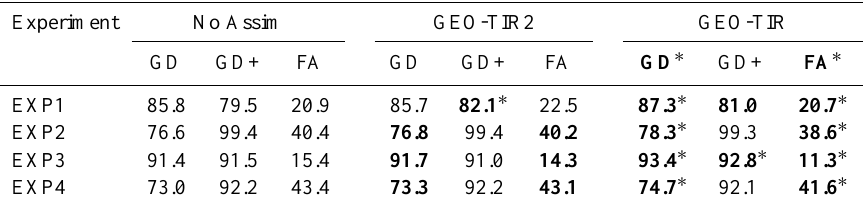
Table 6. Scores for O 3 8-h running average daily maximum (percentage of good detection (GD), percentage of correct forecast above threshold (GD+), percentage of false alarm (FA)) obtained over Europe during July and August 2009 by comparing the control run to the nature run (2nd column), the assimilation run with GEOTIR2 to the nature run (3rd column) and the assimilation run with GEO-TIR to the nature run (4th column). Bold scores indicates that the assimilation run is better than the control run by more than 0.1%, ∗ scores indicates that one of the assimilation runs (GEO-TIR or GEO-TIR2) is better than the other one by more that 0.1%. See text for details about the different scores. Experiment No Assim GEO-TIR2 GEO-TIR GD GD+ FA GD GD+ FA GD ∗ GD+ FA ∗ EXP1 85.8 79.5 20.9